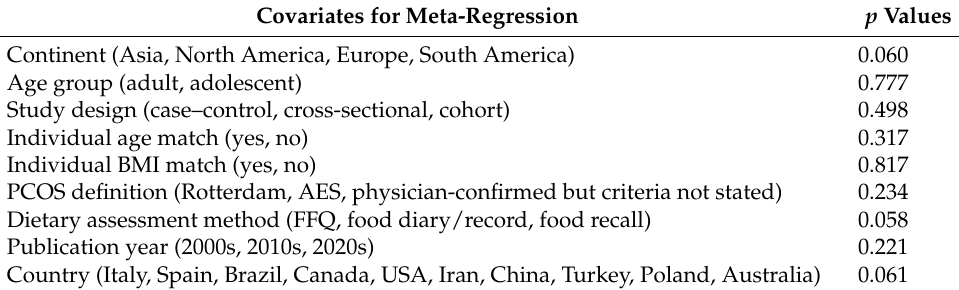
Table 3. Meta-regression of covariates possible for heterogeneity. Covariates for